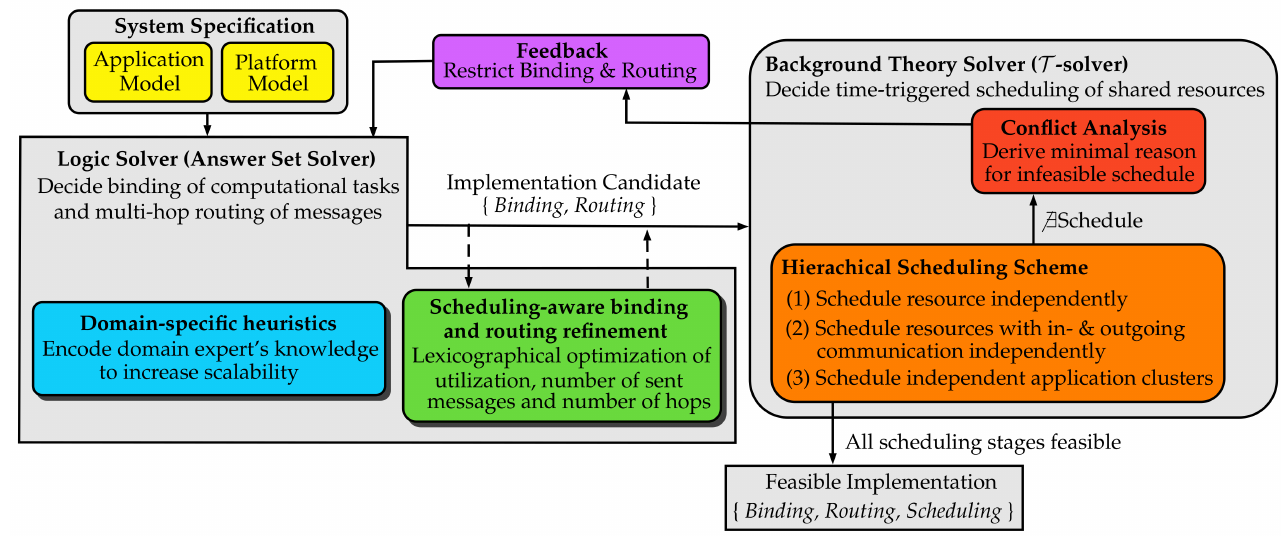
Figure 2. Detailed overview of SMT-based system synthesis with the extensions of the scheduling- aware binding and routing refinement (green box) in the coordinated synthesis approach and the coordinated + DSH approach (green and cyan